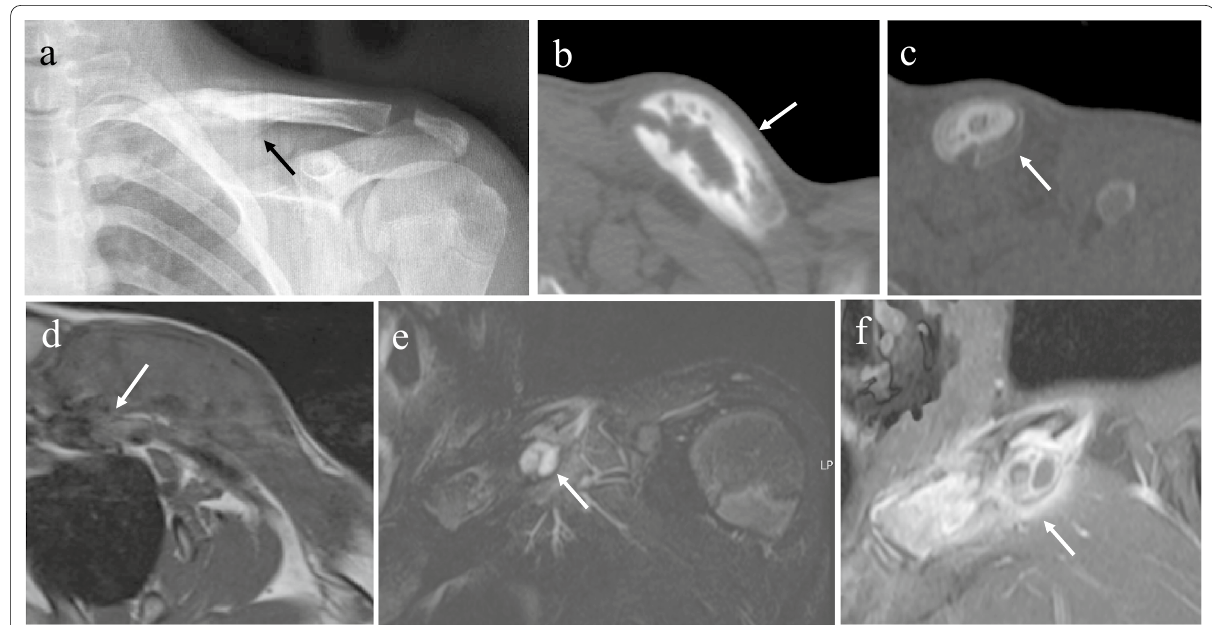
Fig. 6 A 14-year-old boy with a 3-week history of pain and swelling of the left clavicle. Anteroposterior radiograph reveals hyperostosis, sclerosis and periosteal reaction of the medial third of the clavicle ( a ). CT scan illustrates better clavicle periosteal reaction and erosions ( b and c ). Axial T1WI ( d ), coronal FST2WI ( e ) and coronal ceFST1WI ( f ) images show the same findings, in addition to bone marrow edema and heterogeneous enhancement within the clavicle and surrounding soft tissues. Biopsy revealed sterile inflammation. CNO is the most common disease involving the medial third of the clavicle in all age groups